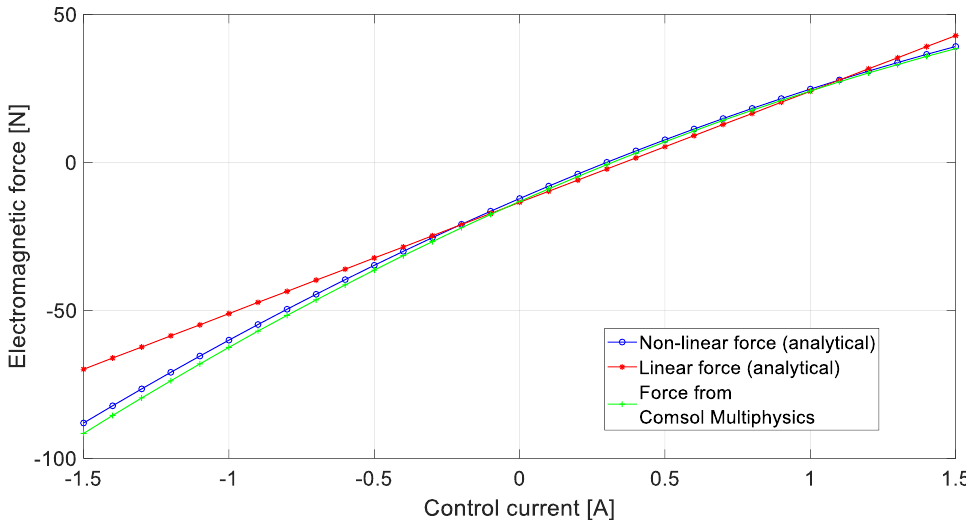
Figure 21. The resultant electromagnetic force generated by the magnetic bearing for different values of the control current for the rotor – shaft raceway displacement is equal to − 0.06 mm.